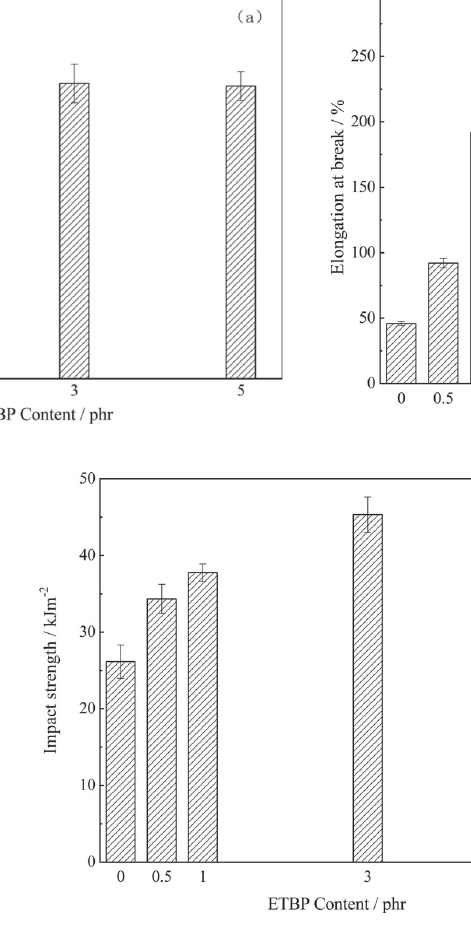
Figure 3: Tensile strength (a), elongation at break (b) and impact strength (c) of the PLA/PBAT blends with different content of